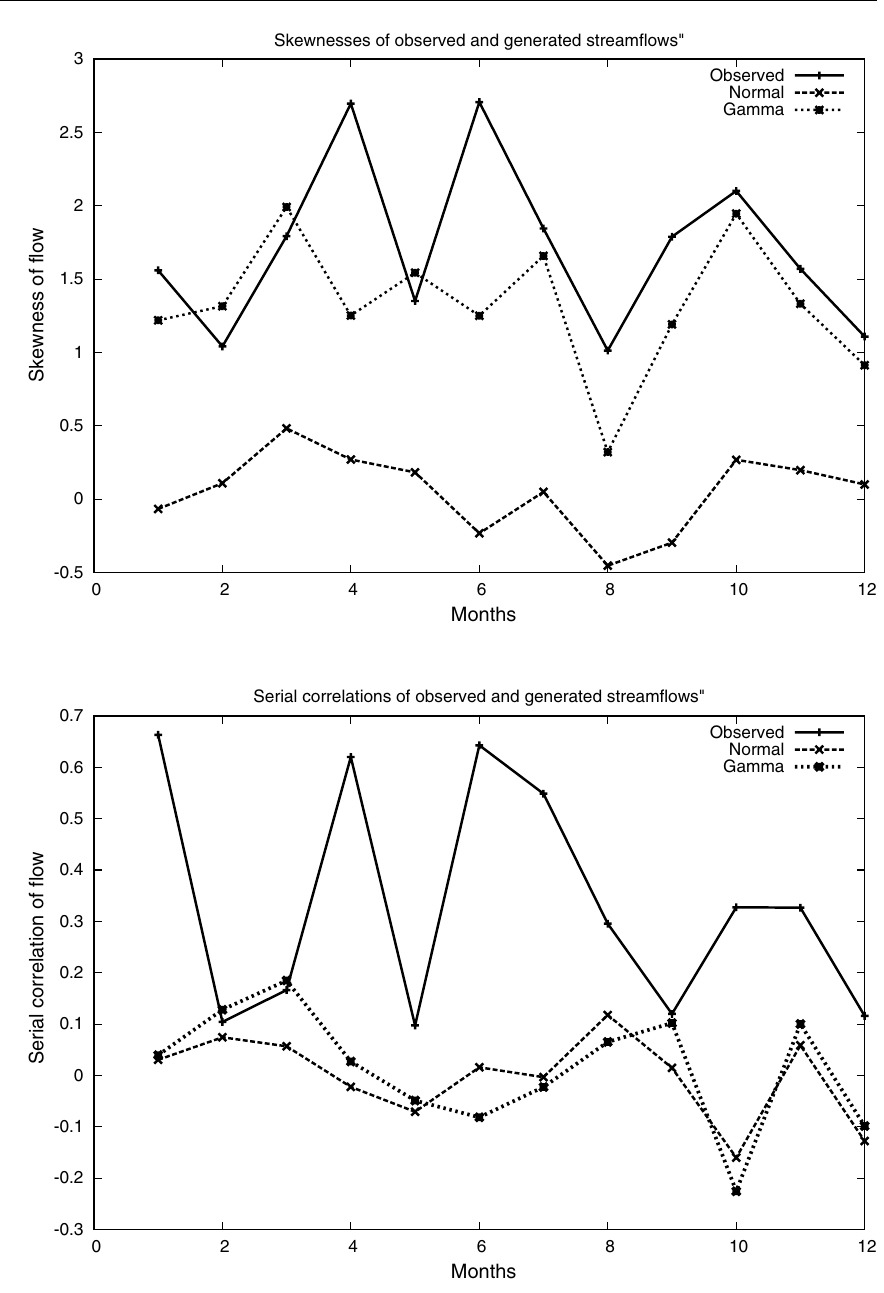
Fig. 17 Historical and generated monthly skewness coefficients of flows in Barakar River (multi-site model)